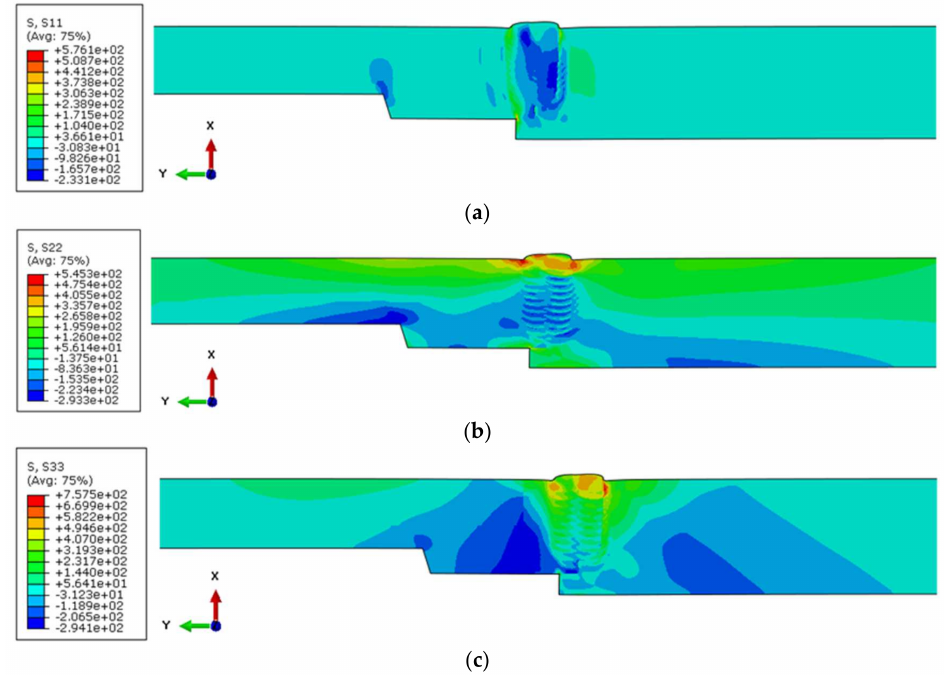
Figure 9. FE prediction of the radial ( a ), axial ( b ) and hoop ( c ) residual stress (MPa) distributions in the DMW joint after girth